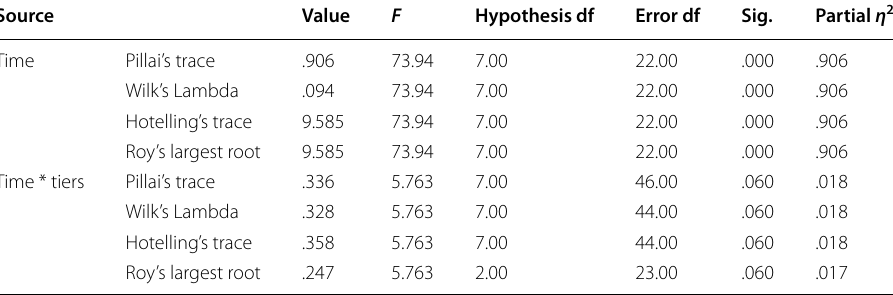
Table 5 Multivariate tests of within-subject effect in the collaborative group Source Value F Hypothesis df Error df Sig. Time